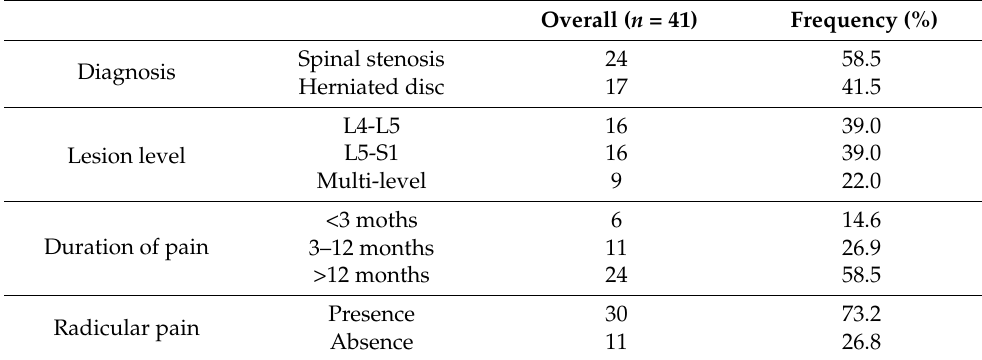
Table 1. Demographic data of 41